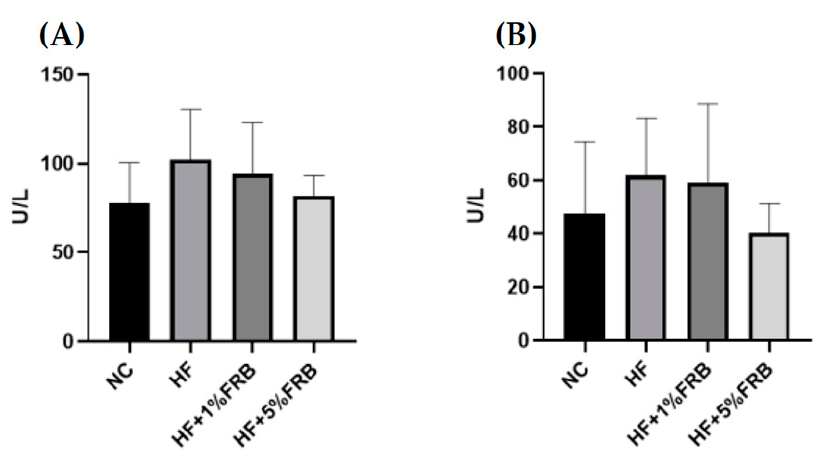
Figure 3. Effects of water extract of fermented rice bran (FRB) on liver function index in aged rats with high-fat (HF) diet feeding. Plasma level of ( A ) aspartate aminotransferase (AST) and ( B ) alanine aminotransferase (ALT). Values are presented as the mean ± standard deviation ( n = 6). * p < 0.05 vs. the normal control (NC) group; significance between two groups was determined using Student’s t -test. In the HF diet-fed groups, differences between groups were determined by a one-way ANOVA with Fisher‘s post hoc test.